Question: Condense the content of this figure into a single sentence.
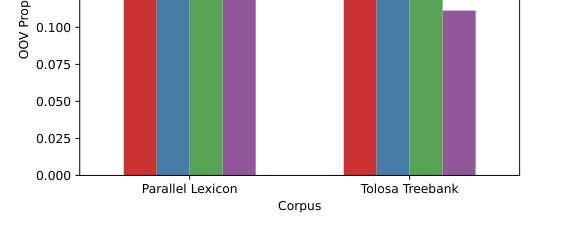
Answer: Proportion of vocabulary items in each evalua- tion corpus that did not appear in the fine-tuning dataset. Red: Lengadocian; Blue: Gascon; Green: Lemosin; Purple: Provençau.